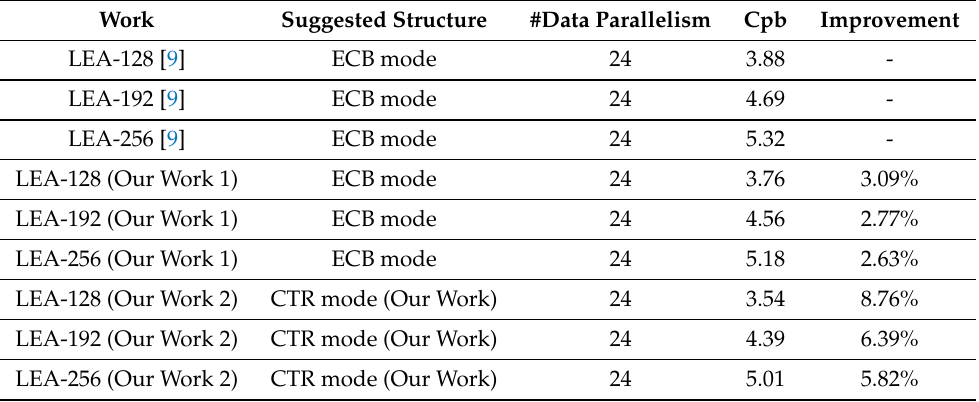
Table 5. Running time comparison of LEA implementation in ARMv8 architecture. (Our Work 1: Proposed parallel implementation, Our Work 2: Proposed CTR mode optimization, #Data paral- lelism: the number of encryptions performed simultaneously on NEON engine, Cpb: Clock per byte, and Improvement: Improved performance compared to previous